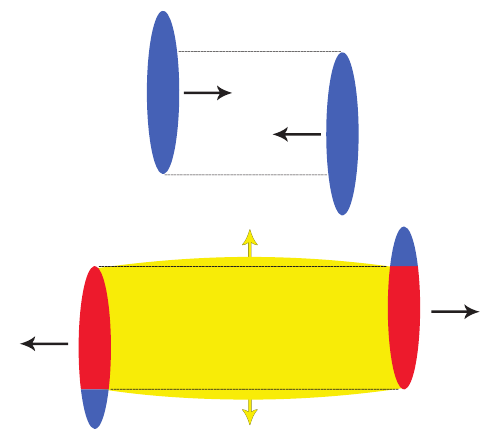
Figure 5. Schematic representation of the three-source model for relativistic heavy-ion collisions at RHIC and LHC energies in the center-of-mass system: Following the collision and slowing down ( stopping ) of the two Lorentz-contracted slabs (blue), the fireball region (center, yellow) expands anisotropically in longitudinal and transverse direction. At midrapidity, it represents the main source of particle production. The two fragmentation sources (red) contribute to particle production, albeit mostly in the forward and backward rapidity regions. In stopping, these are the only sources. From